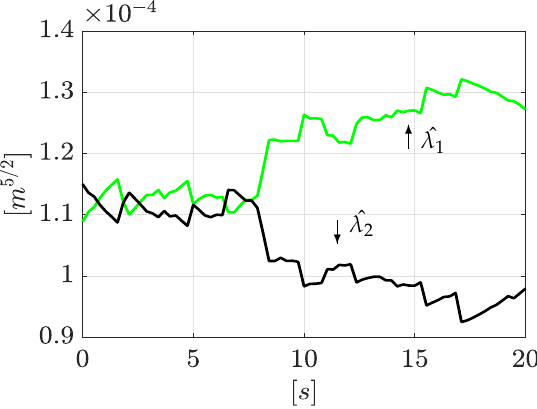
Figure 7. Estimation of leak magnitudes.